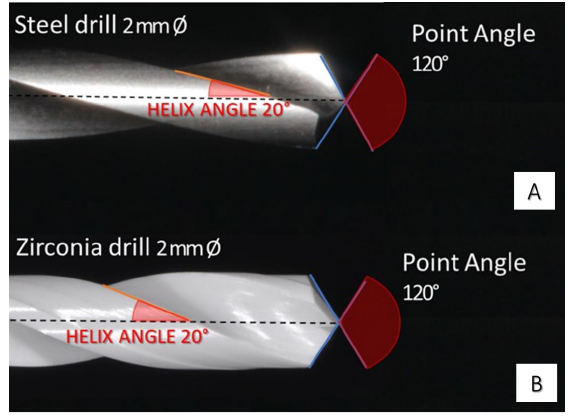
Figure 2. ( A ) Steel (SS) 2 mm diameter drill; point angle 120 ◦ , helix angle 20 ◦ . ( B ) Zirconia 2 mm diameter drill with positive point angle 120 ◦ , helix angle 20 ◦